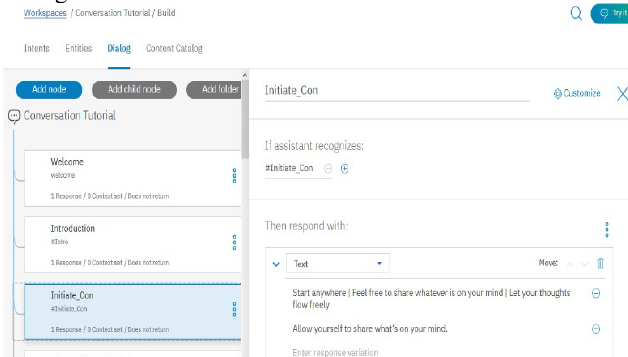
Figure 10. IBM Watson Assistant Dialog configuration Interface